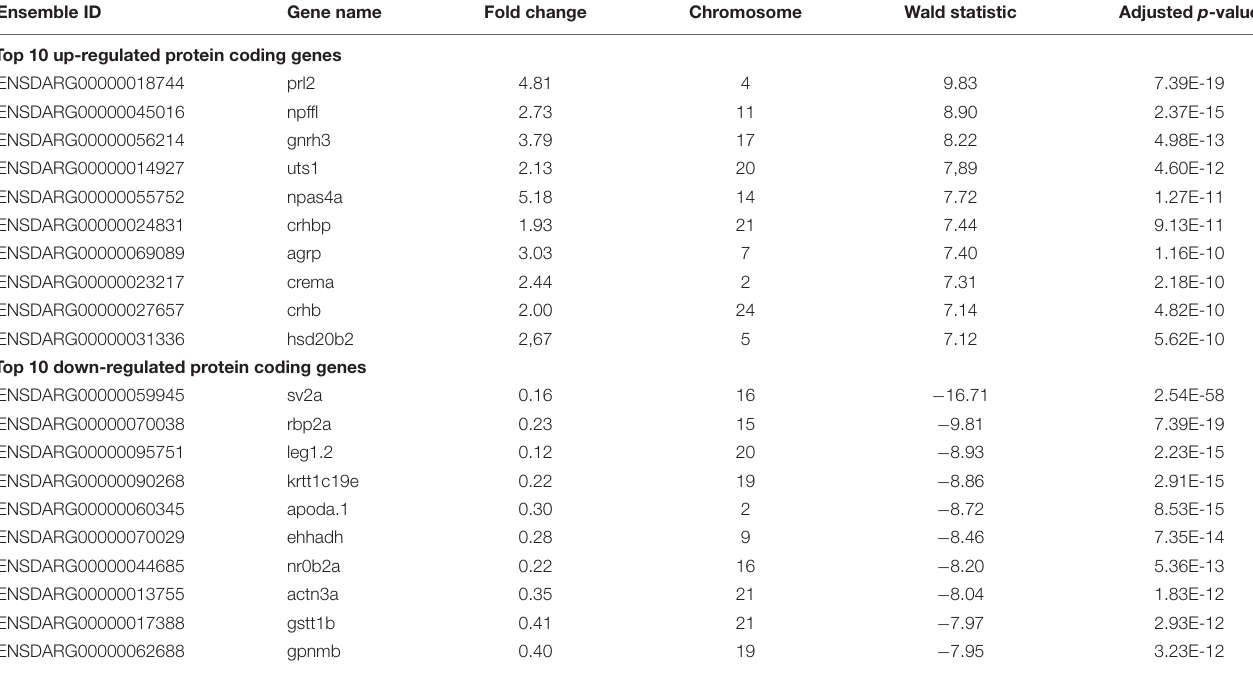
TABLE 1 | Top 10 up- and down-regulated genes sorted by Wald statistic. Ensemble ID Gene name Fold change Chromosome Wald statistic Adjusted p